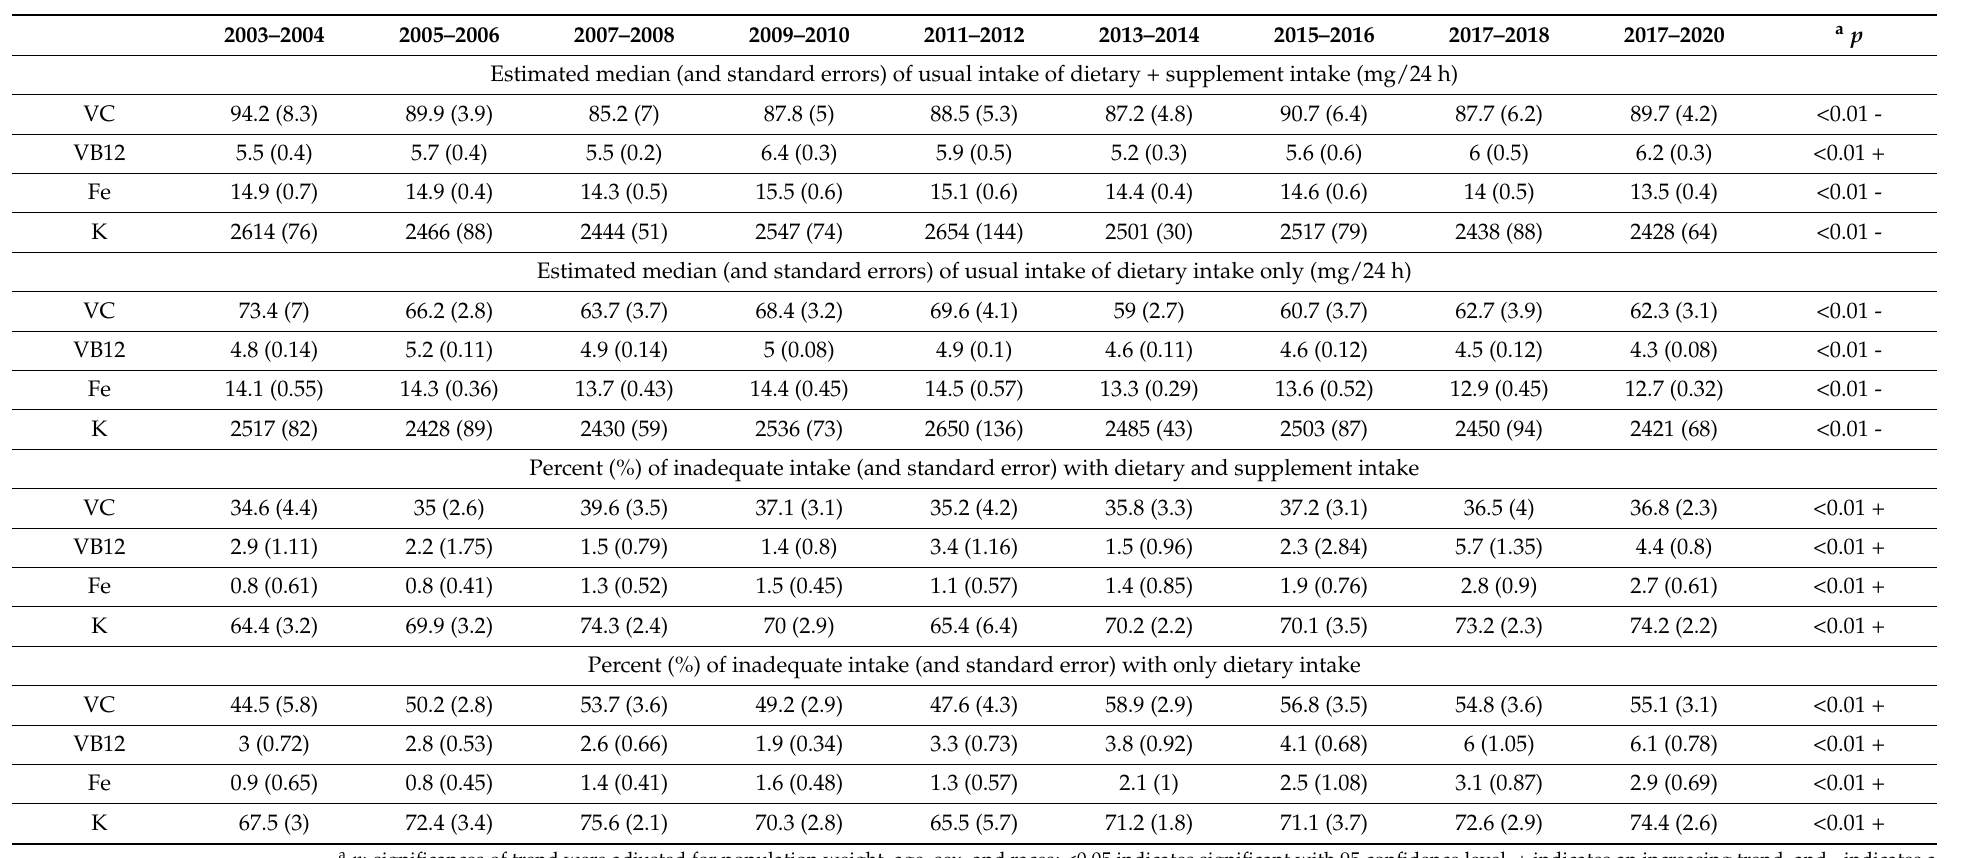
Table 4. Estimated medians and percentages of inadequacies of usual intakes of VC, VB12, Fe, and K for US type 2 diabetic adults between sample years